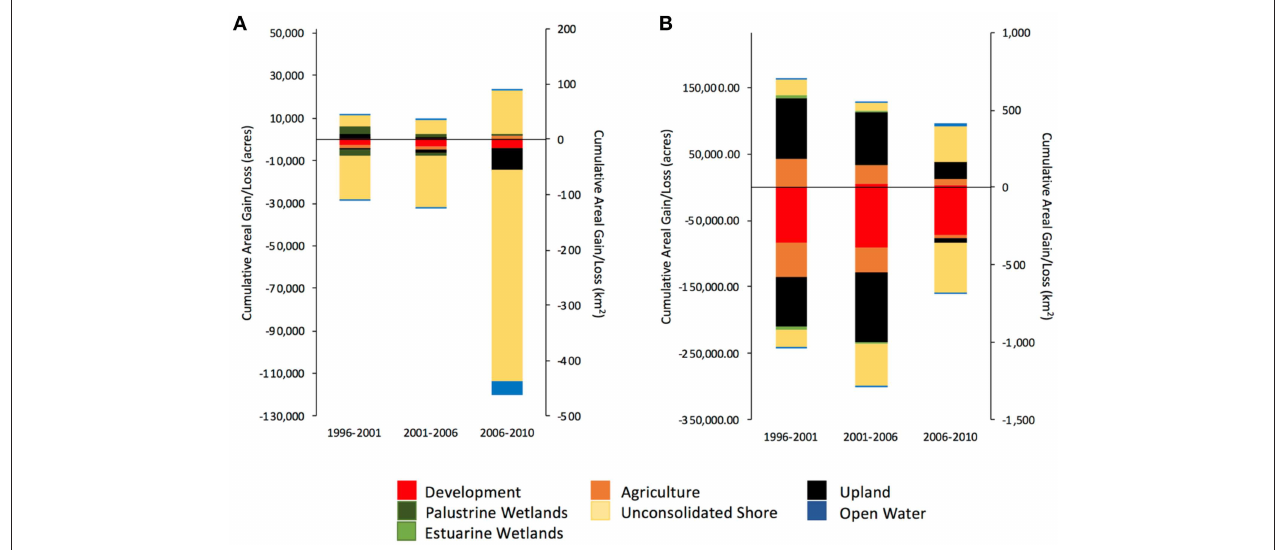
FIGURE 1 | Rate of (A) estuarine wetland gain/loss (acres and km 2 per year) and (B) palustrine wetland gain/loss in United States shoreline counties from 1996 to 2001, 2001 to 2006, and 2006 to